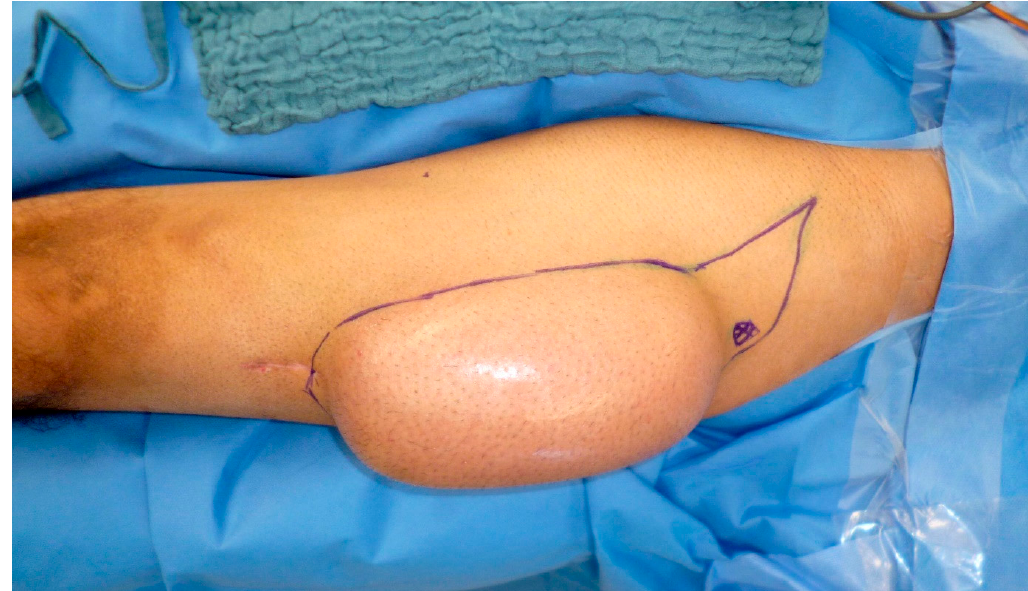
Figure 5. A rectangular expander has been implanted epifascially next to a suitable ALT perforator using intra-operative duplex ultrascan and subsequently filled with 700cc saline solution to pre-expand the planned ALT flap.